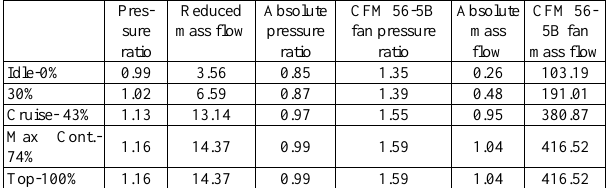
Table 5. Parameter of CFM 56-5B V = 0.2 Ma, H = 0 m